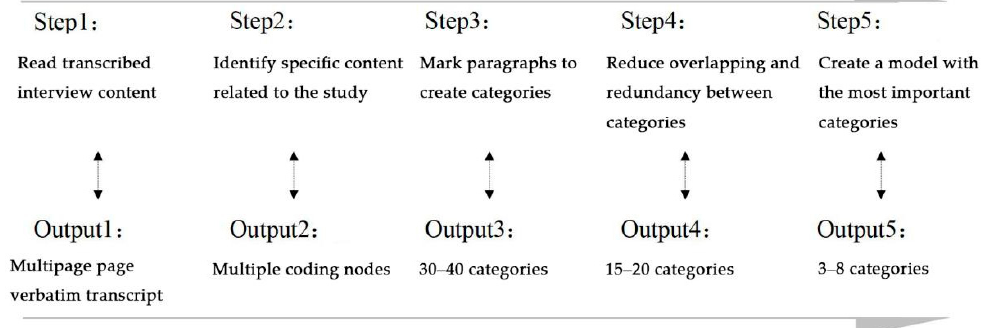
Figure 1. The coding process in inductive analysis.